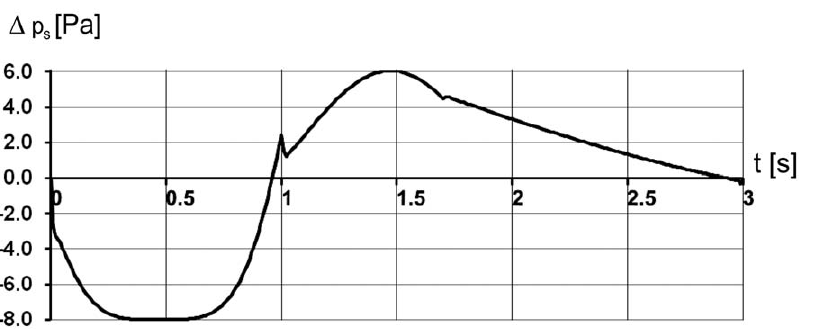
Figure 3. Pressure change in the air sac during one breathing cycle. 1 s corresponds to end-inspiration.